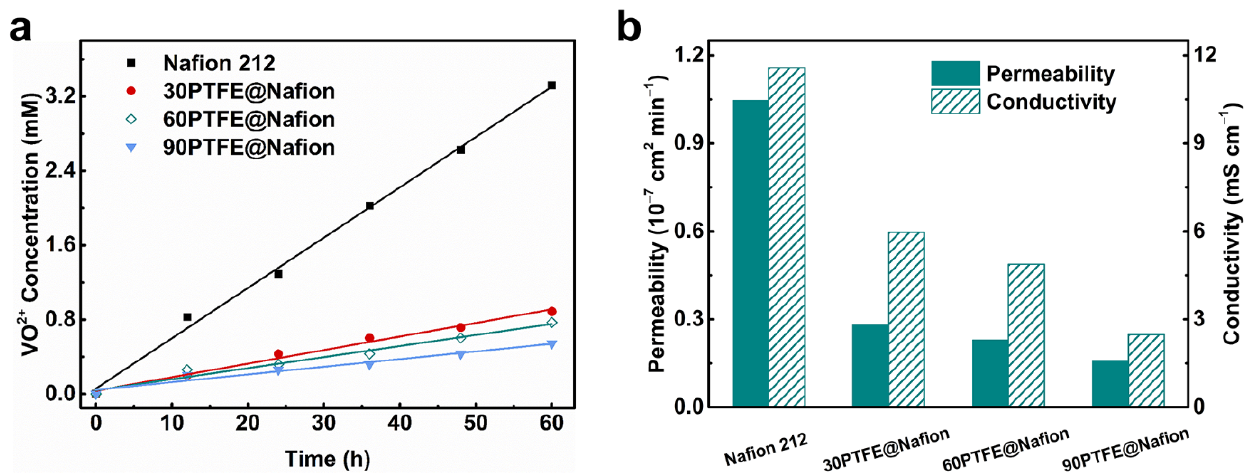
Figure 4. Ion permeation properties of composite membranes. ( a ) Time-dependent concentration of VO 2+ ions, ( b ) permeability and conductivity.